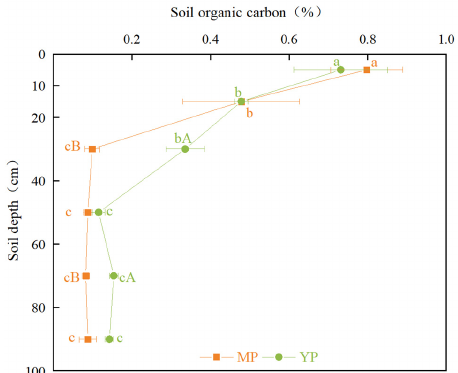
Figure 4. Changes of soil organic carbon along 0 − 100 cm soil profiles in the mature (MP) and young poplar (YP) plantations. Different lowercase letters denote significant differences among different depths within the same plantation; while different uppercase letters denote significant differences between different plantations within the same soil depth ( p < 0.05).